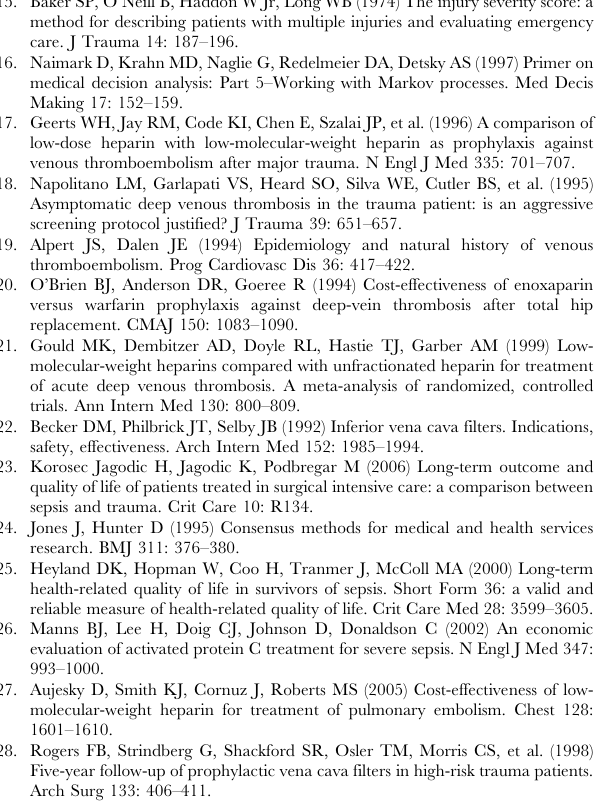
Figure S1 Article selection.